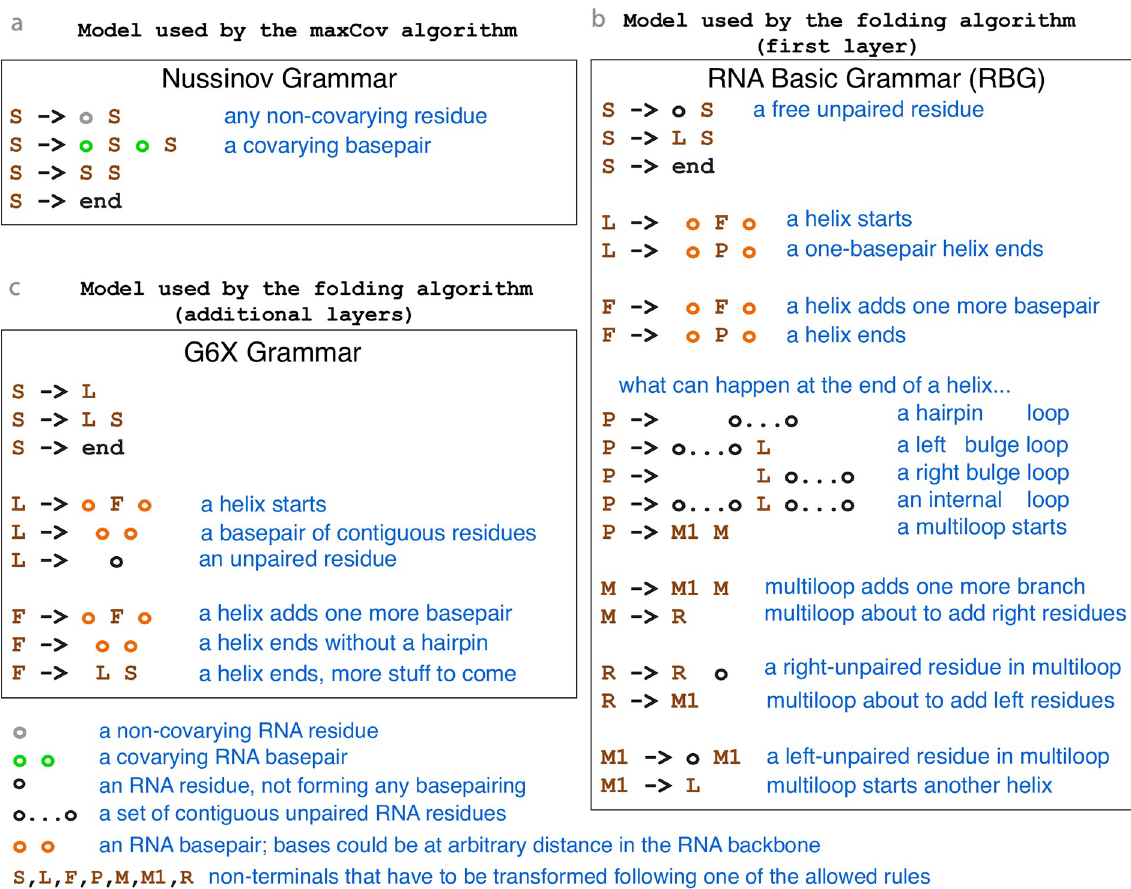
Fig 2. RNA models used by the CaCoFold algorithm. ( a ) The Nussinov grammar implemented by the maxCov algorithm uses the R-scape E- values of the significantly covarying pairs, and maximizes the sum of -log(E-value). ( b ) The RBG model used by the first layer of the folding algorithm. ( c ) The G6X model used by the rest of the layers completing the non-nested part of the RNA structure. For the RBG and G6X models, the F nonterminal is a shorthand for 16 different non-terminals that represent stacked basepairs. The three models are unambiguous, that is, given any nested structure, there is always one possible and unique way in which the structure can be formulated by following the rules of the grammar.